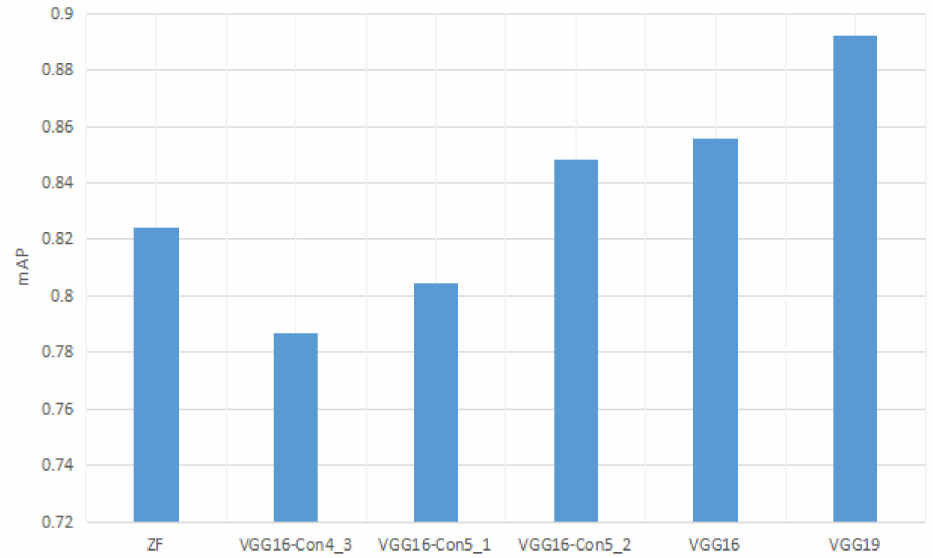
Figure 5. Comparison of different feature extraction methods.